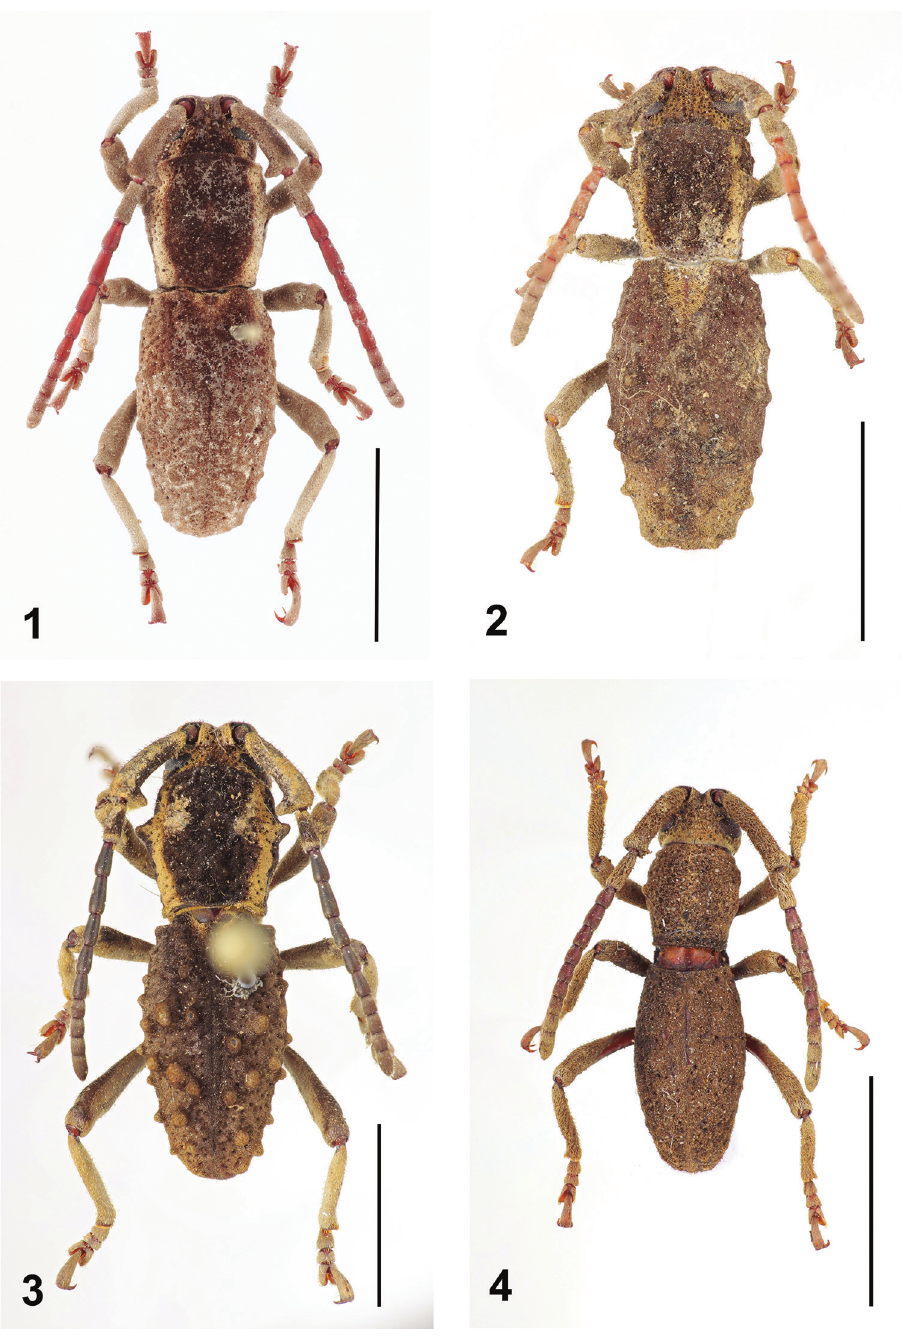
Figures 1–4. Dorsal habitus of Anexodus spp.: 1 Anexodus aquilus Pascoe, holotype male 2 Anexodus aquilus Pascoe, female (= holotype of Anexodus kuntzeni Kriesche) 3 Anexodus aquilus Pascoe, large male from Trus Madi 4 Anexodus syptakovae sp. n., holotype male. Scale bar = 5